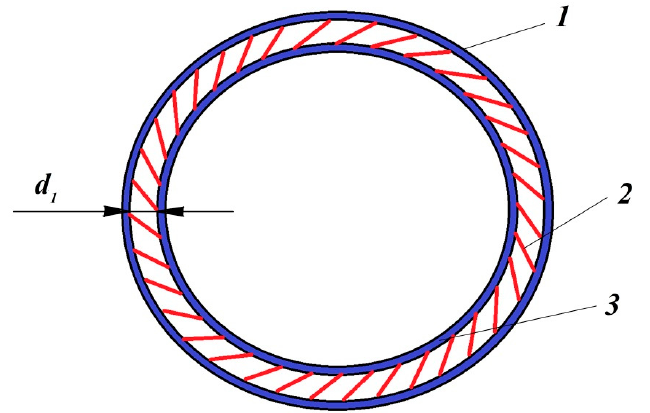
Figure 5. Schematic view of capacitive rotation motor. 1 —Stator: ferroelectric–metal structure on a substrate; 2 —free metal films (“petals”), fixed at one end on the stator surface; 3 —rotor.